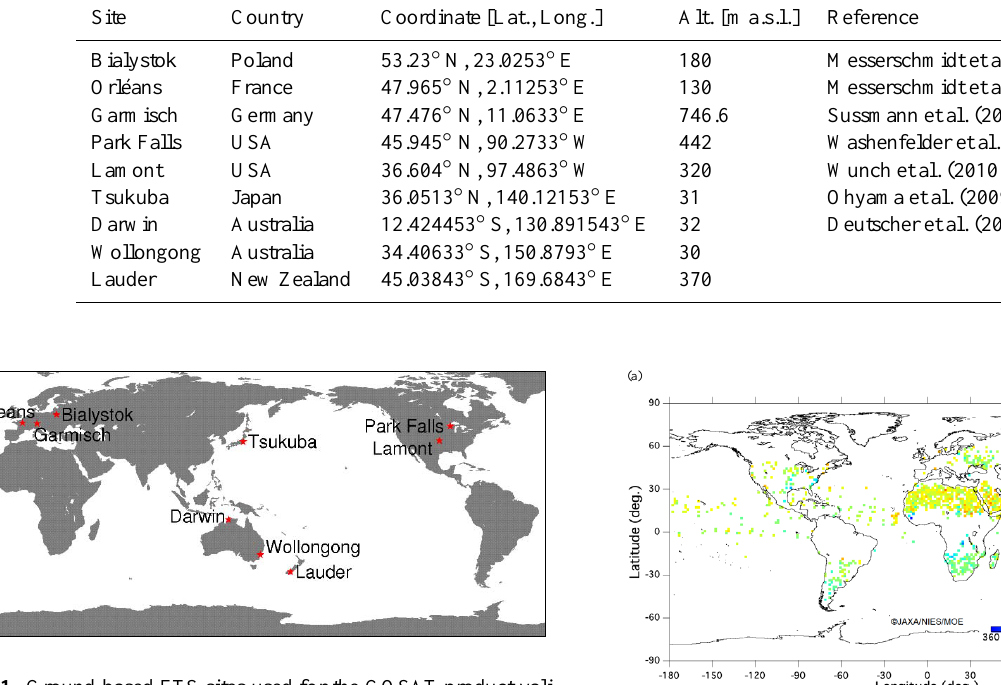
Fig. 1. Ground-based FTS sites used for the GOSAT product vali- dation in the present study.